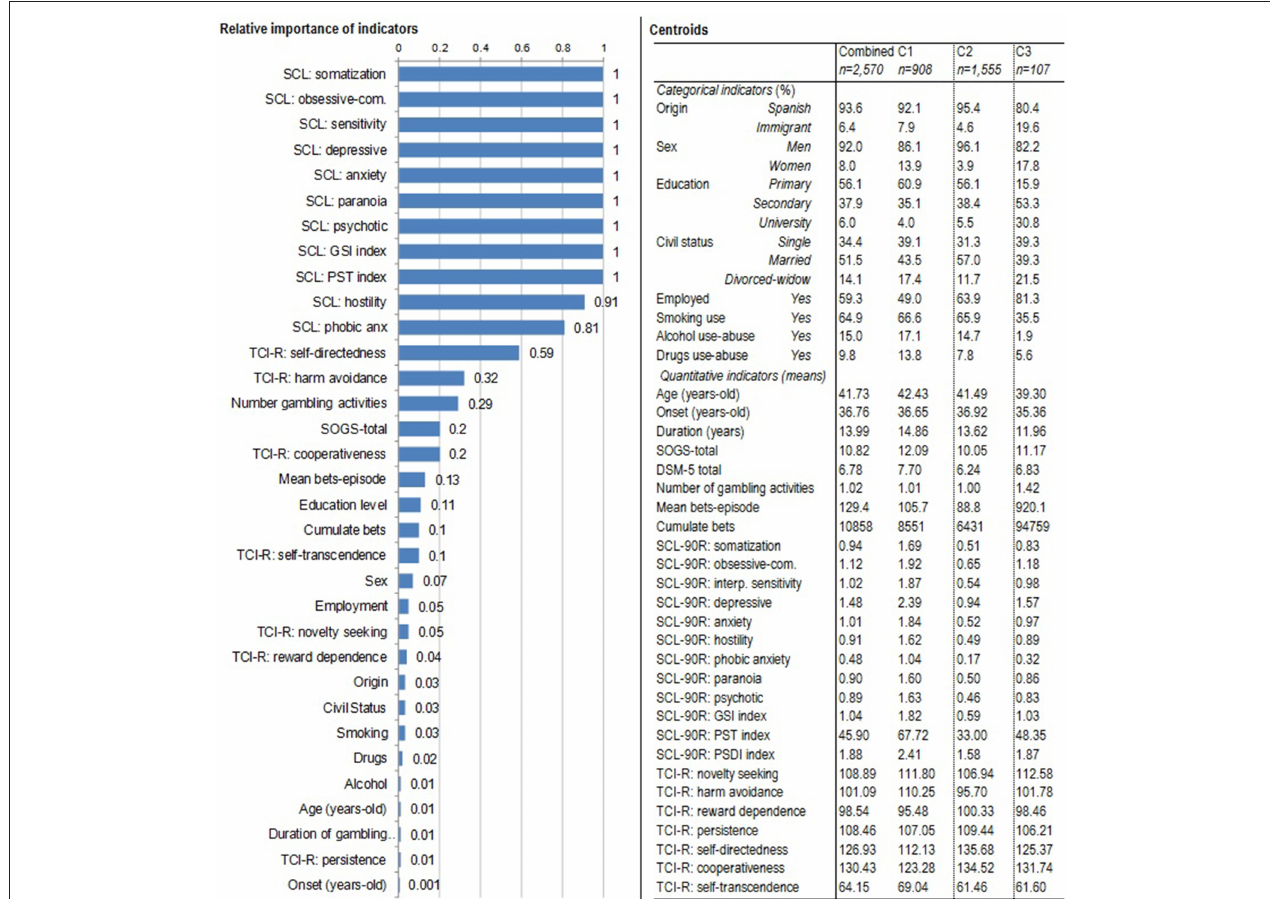
FIGURE 1 | Clustering summary: relative importance of each indicator and centroids.